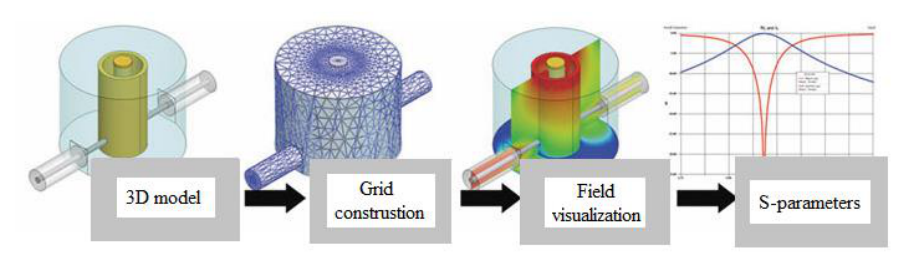
Fig. 2. Stages of work in